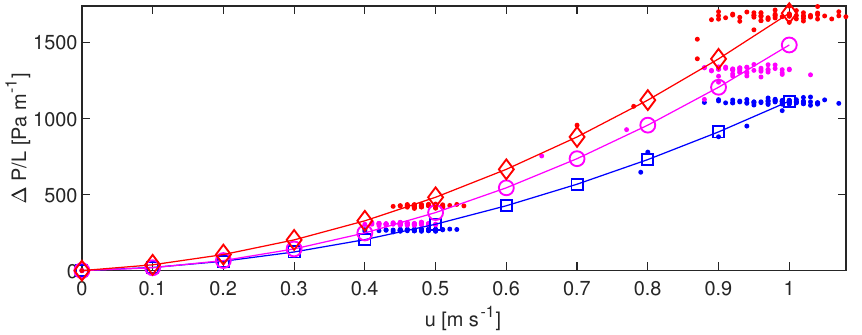
Figure 12. Darcy-Forchheimer Equation (5) fitted to the experimental data of pressure drop ( ∆ P ) and inlet air velocity ( u ) for different water flows ( Q ) for the BC material. Blue: 2 L min − 1 m − 1 , magenta: 6.2 L min − 1 m − 1 and red: 10 L min − 1 m − 1 .